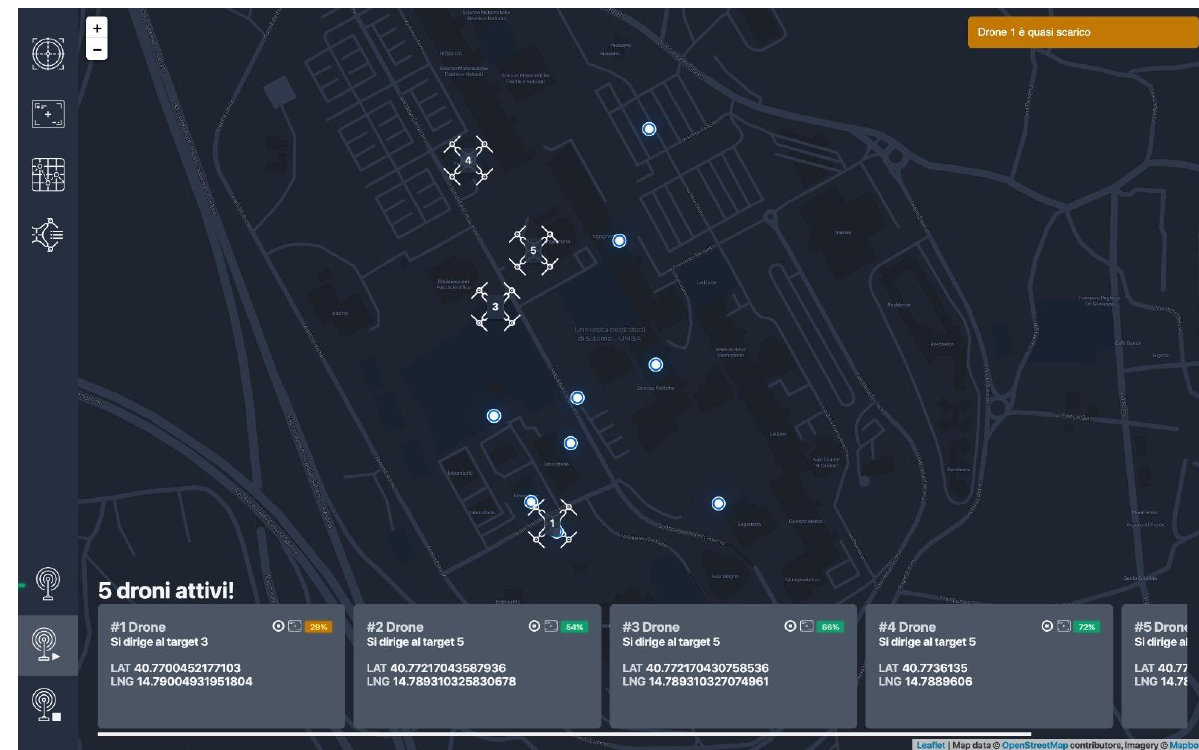
Figure 2. The GCS interface during the mission execution in case the drone battery is ≤ 30%.